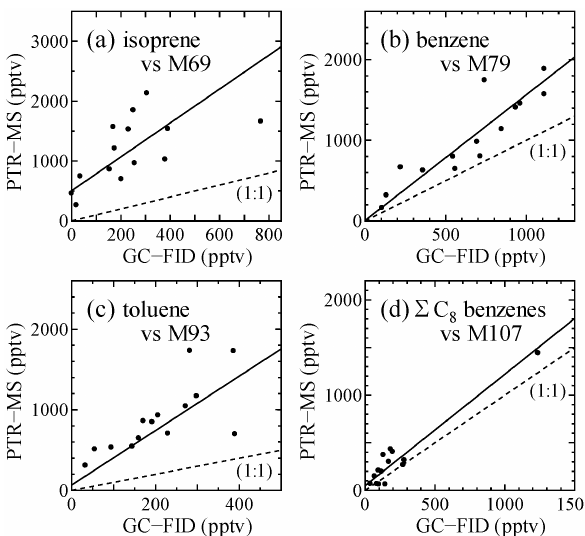
Fig. 2. Comparison of PTR-MS data with GC-FID data for (a) iso- prene, (b) benzene, (c) toluene, and (d) 6 C 8 benzenes; 10-min averaged PTR-MS data are used for the comparison. The best-fit lines obtained by RMA regression and y = x lines are indicated by solid lines and dashed lines, respectively. The best-fit line: (a) y =(2.8 ± 1.4) x + (505 ± 403), r 2 =0.36, (b) y =(1.6 ± 0.4) x + (6 ± 306), r 2 =0.82, (c) y =(3.4 ± 1.7) x + (67 ± 393), r 2 =0.53, (d) y =(1.2 ± 0.2) x + (50 ± 78), r 2